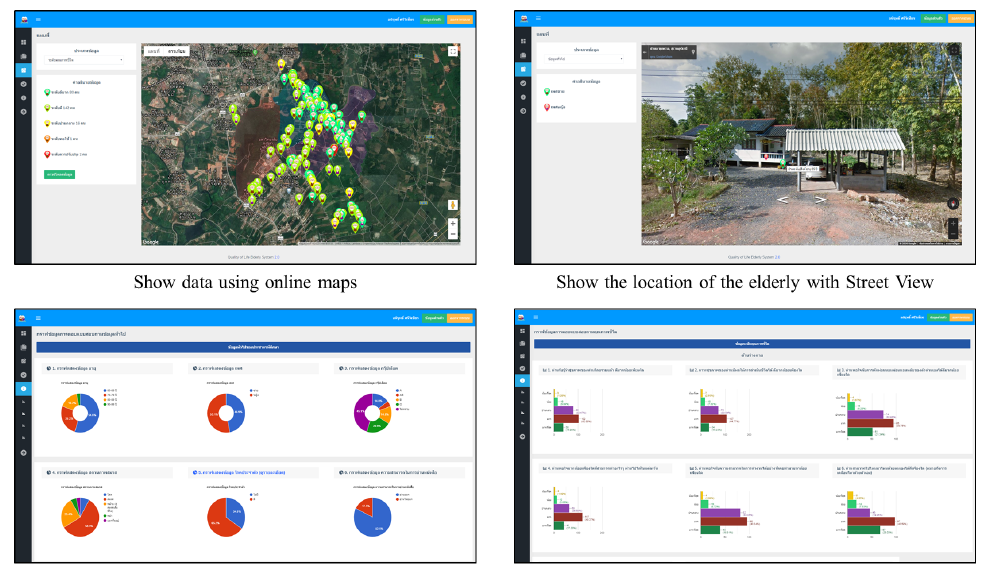
Figure 7. Summary of general information on the population sample.